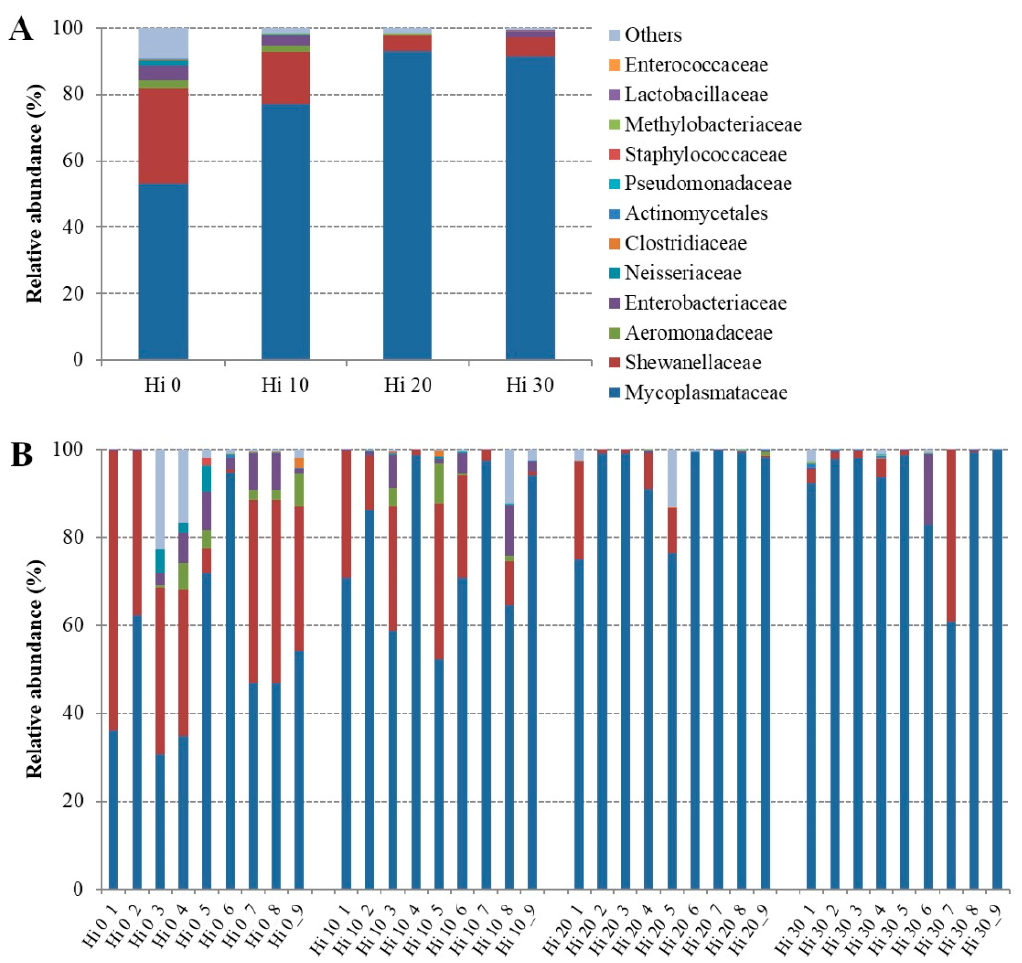
Figure 3. Relative abundance (%) of the overall most prevalent bacterial families in each dietary groups ( A ) and individual fish ( B ). In the figure, all taxa with an overall abundance of ≥ 0.01% were reported. Table 3. Results of Permutational multivariate analysis of variance (PERMANOVA) and Analysis of similarity (ANOSIM) based on Bray–Curtis and binary Bray–Curtis dissimilarities using abundance data of mucosa-associated bacterial communities. Significant p -values are in